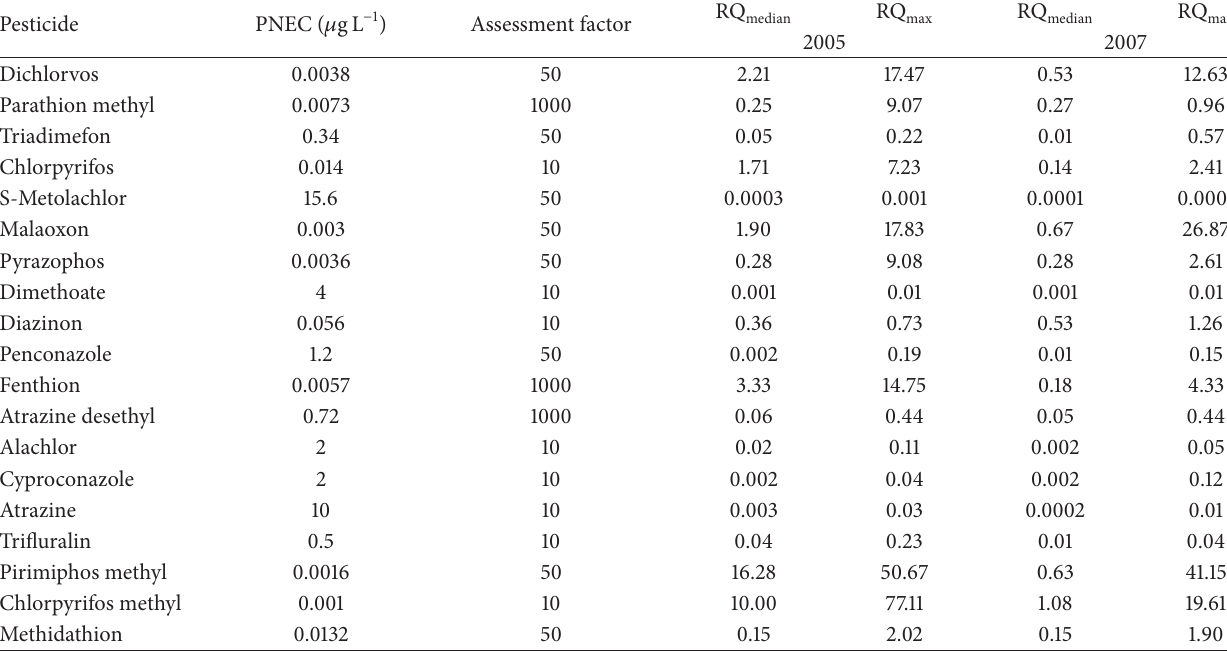
Table 6: Environmental risk of pesticides detected in Acheloos River as risk quotient (MEC/PNEC) based on median and maximum residue values for 2005 and 2007.